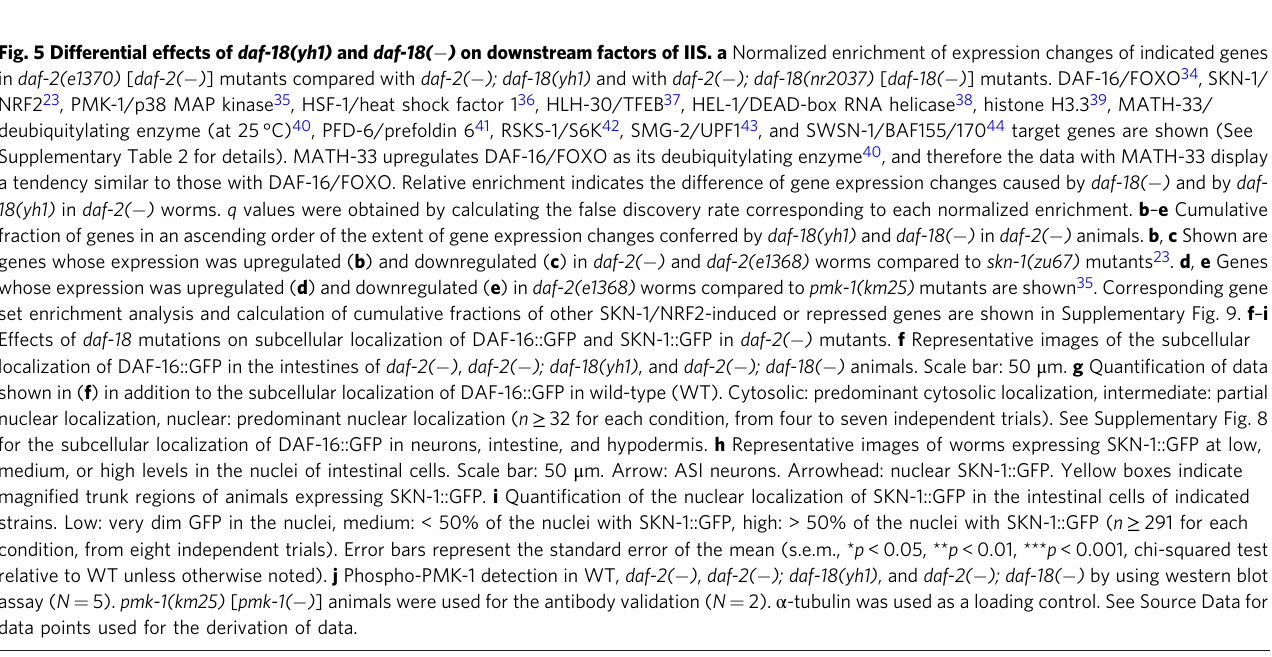
Fig. 5 Differential effects of daf-18(yh1) and daf-18( − ) on downstream factors of IIS. a Normalized enrichment of expression changes of indicated genes in daf-2(e1370) [ daf-2( − ) ] mutants compared with daf-2( − ); daf-18(yh1) and with daf-2( − ); daf-18(nr2037) [ daf-18( − ) ] mutants. DAF-16/FOXO 34 , SKN-1/ NRF2 23 , PMK-1/p38 MAP kinase 35 , HSF-1/heat shock factor 1 36 , HLH-30/TFEB 37 , HEL-1/DEAD-box RNA helicase 38 , histone H3.3 39 , MATH-33/ deubiquitylating enzyme (at 25 °C) 40 , PFD-6/prefoldin 6 41 , RSKS-1/S6K 42 , SMG-2/UPF1 43 , and SWSN-1/BAF155/170 44 target genes are shown (See Supplementary Table 2 for details). MATH-33 upregulates DAF-16/FOXO as its deubiquitylating enzyme 40 , and therefore the data with MATH-33 display a tendency similar to those with DAF-16/FOXO. Relative enrichment indicates the difference of gene expression changes caused by daf-18( − ) and by daf- 18(yh1) in daf-2( − ) worms. q values were obtained by calculating the false discovery rate corresponding to each normalized enrichment. b – e Cumulative fraction of genes in an ascending order of the extent of gene expression changes conferred by daf-18(yh1) and daf-18( − ) in daf-2( − ) animals. b , c Shown are genes whose expression was upregulated ( b ) and downregulated ( c ) in daf-2( − ) and daf-2(e1368) worms compared to skn-1(zu67) mutants 23 . d , e Genes whose expression was upregulated ( d ) and downregulated ( e ) in daf-2(e1368) worms compared to pmk-1(km25) mutants are shown 35 . Corresponding gene set enrichment analysis and calculation of cumulative fractions of other SKN-1/NRF2-induced or repressed genes are shown in Supplementary Fig. 9. f – i Effects of daf-18 mutations on subcellular localization of DAF-16::GFP and SKN-1::GFP in daf-2( − ) mutants. f Representative images of the subcellular localization of DAF-16::GFP in the intestines of daf-2( − ) , daf-2( − ); daf-18(yh1) , and daf-2( − ); daf-18( − ) animals. Scale bar: 50 μ m. g Quanti fi cation of data shown in ( f ) in addition to the subcellular localization of DAF-16::GFP in wild-type (WT). Cytosolic: predominant cytosolic localization, intermediate: partial nuclear localization, nuclear: predominant nuclear localization ( n ≥ 32 for each condition, from four to seven independent trials). See Supplementary Fig. 8 for the subcellular localization of DAF-16::GFP in neurons, intestine, and hypodermis. h Representative images of worms expressing SKN-1::GFP at low, medium, or high levels in the nuclei of intestinal cells. Scale bar: 50 μ m. Arrow: ASI neurons. Arrowhead: nuclear SKN-1::GFP. Yellow boxes indicate magni fi ed trunk regions of animals expressing SKN-1::GFP. i Quanti fi cation of the nuclear localization of SKN-1::GFP in the intestinal cells of indicated strains. Low: very dim GFP in the nuclei, medium: < 50% of the nuclei with SKN-1::GFP, high: > 50% of the nuclei with SKN-1::GFP ( n ≥ 291 for each condition, from eight independent trials). Error bars represent the standard error of the mean (s.e.m., * p < 0.05, ** p < 0.01, *** p < 0.001, chi-squared test relative to WT unless otherwise noted). j Phospho-PMK-1 detection in WT, daf-2( − ) , daf-2( − ); daf-18(yh1) , and daf-2( − ); daf-18( − ) by using western blot data points used for the derivation of